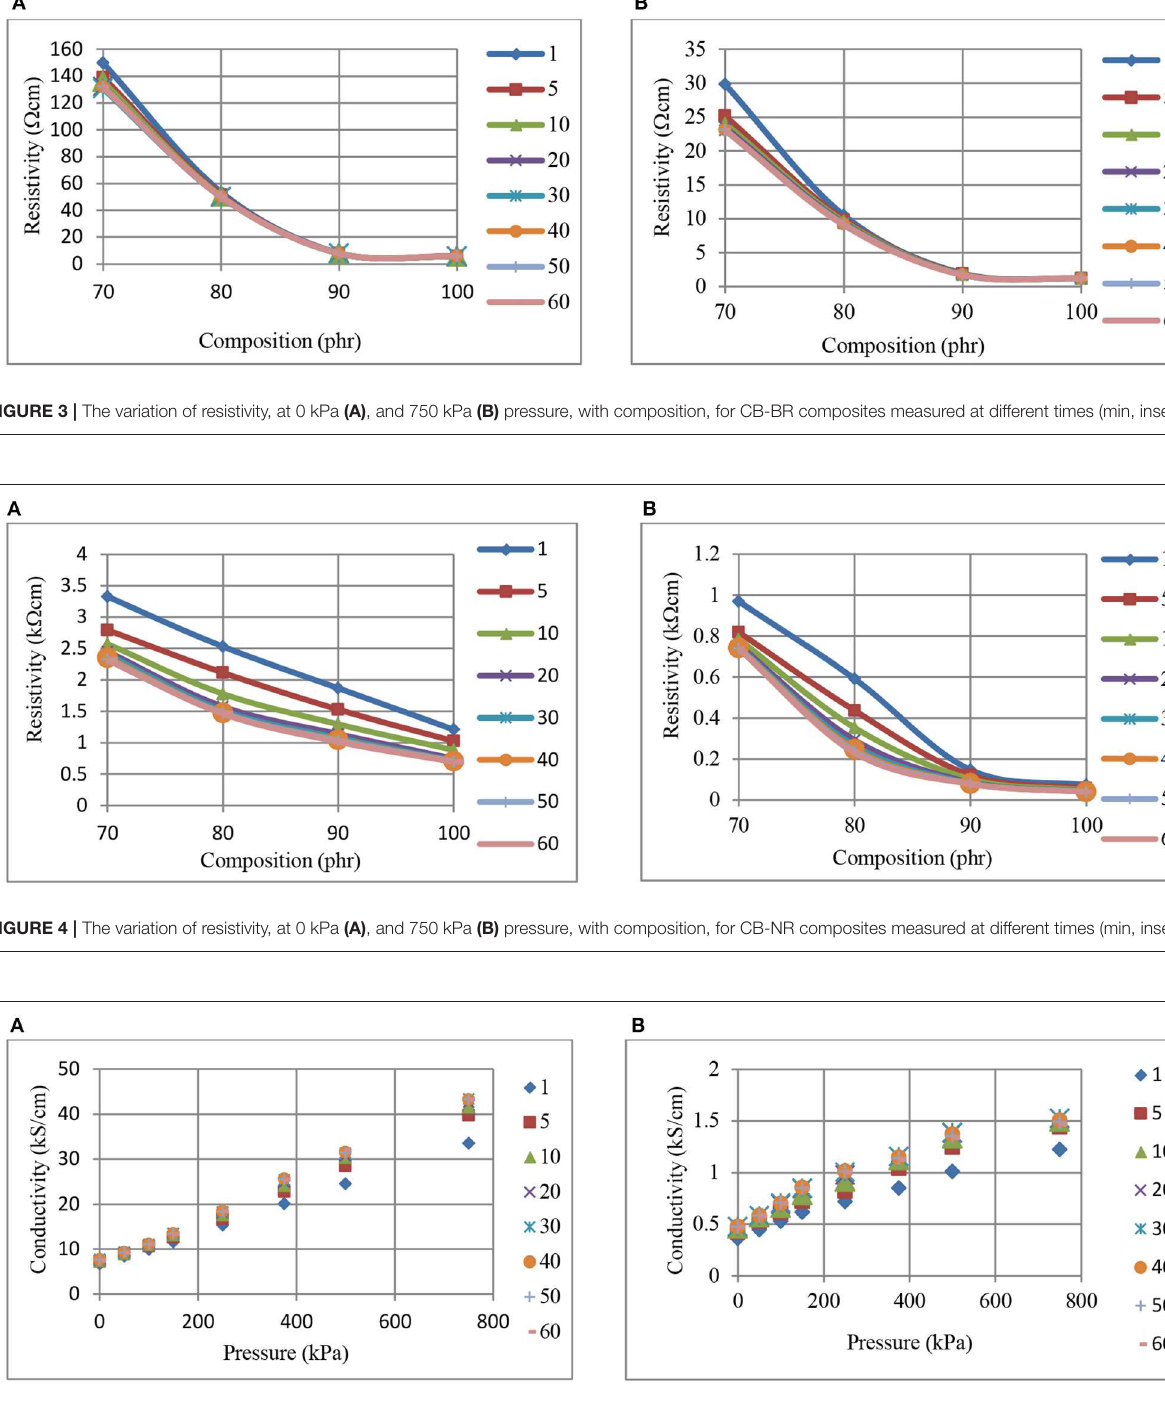
FIGURE 5 | The change in conductivity with pressure and time (min, inset right), for BR (A) , and NR (B) composites containing 70 phr CB.